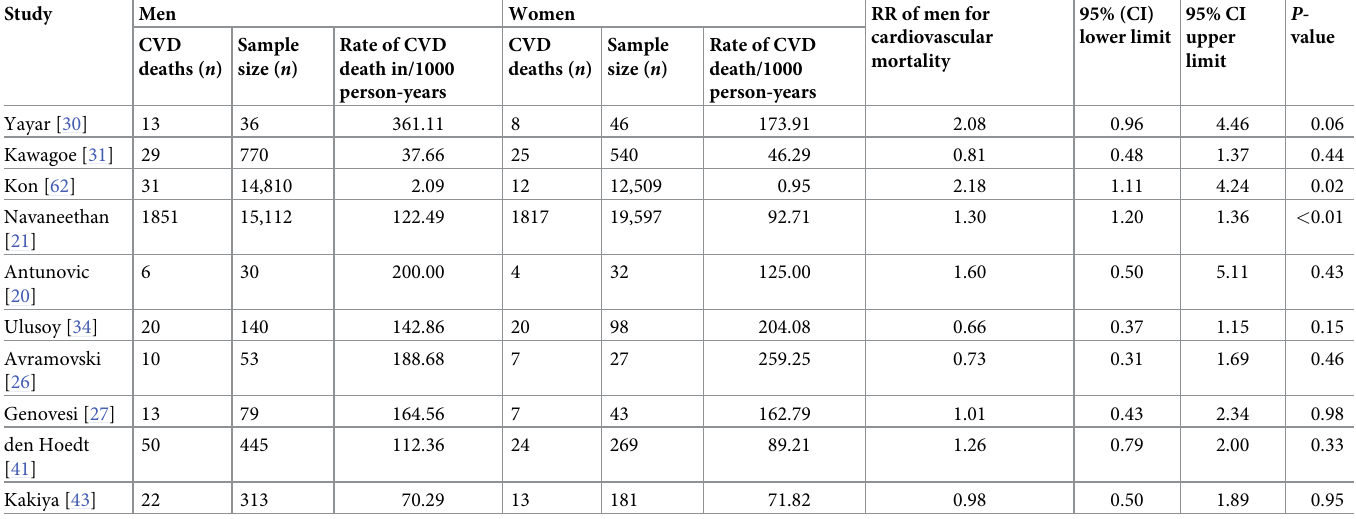
Table 4 summarises the results of the subgroup analyses. There was no statistically significant difference in risk estimate between any of the subgroups. When restricted to the 28 high- Table 3. Summary of additional data from studies not reporting risk estimates. Study